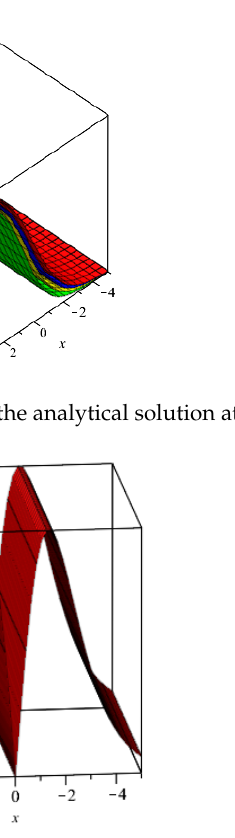
Figure 4. Behavior of the absolute error of problem